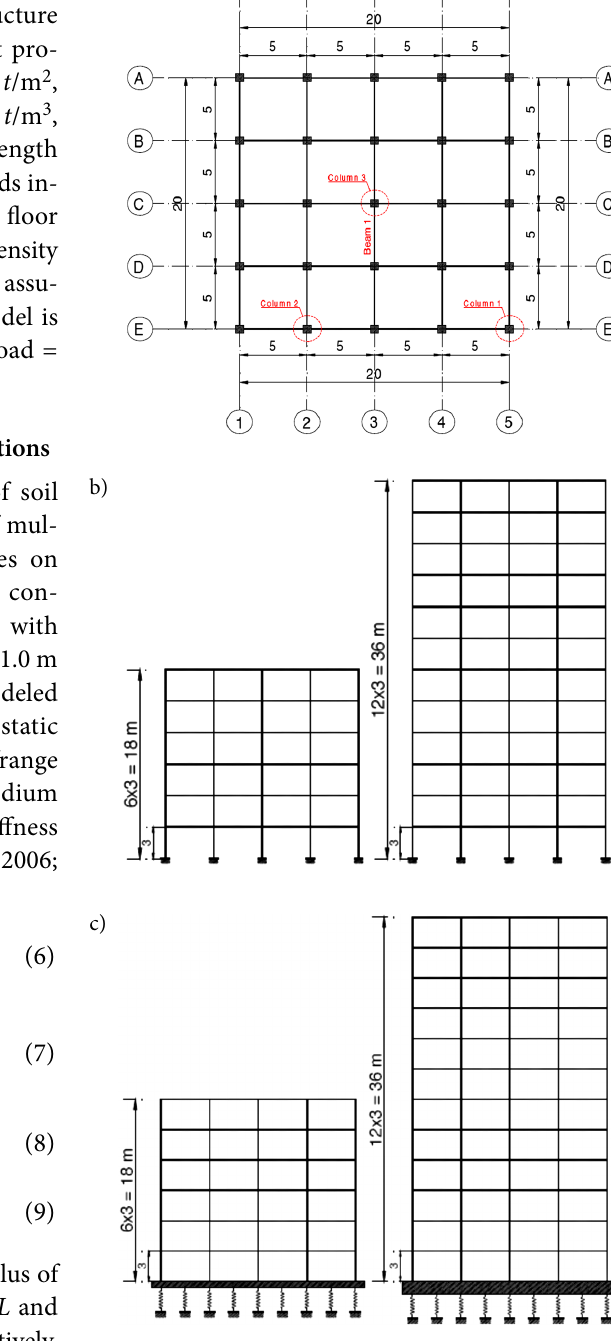
Fig. 2. Configuration of 6-story and 12-story buildings models: a) plan configuration, b) Elevation of fixed base model “NSSI model”, c) Elevation of Soil Structure Interaction Table 1. Elastic Properties and stiffness of soil area spring element.